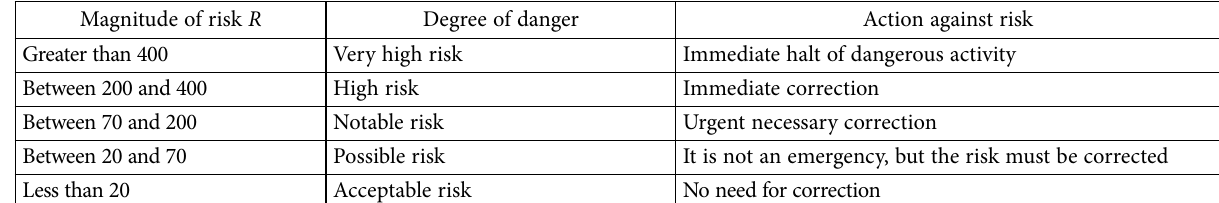
Table 2. Action in relation to degree of